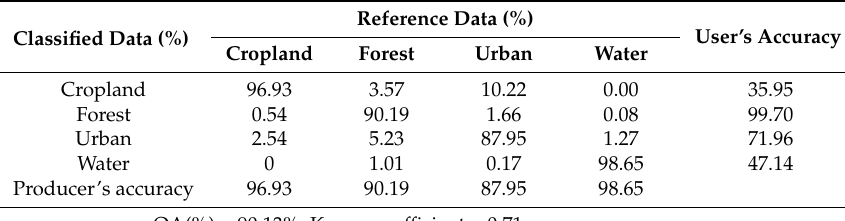
Table 4. Confusion matrix of classification results from the proposed method. Table 5. Confusion matrix of classification results from the CCDC method.